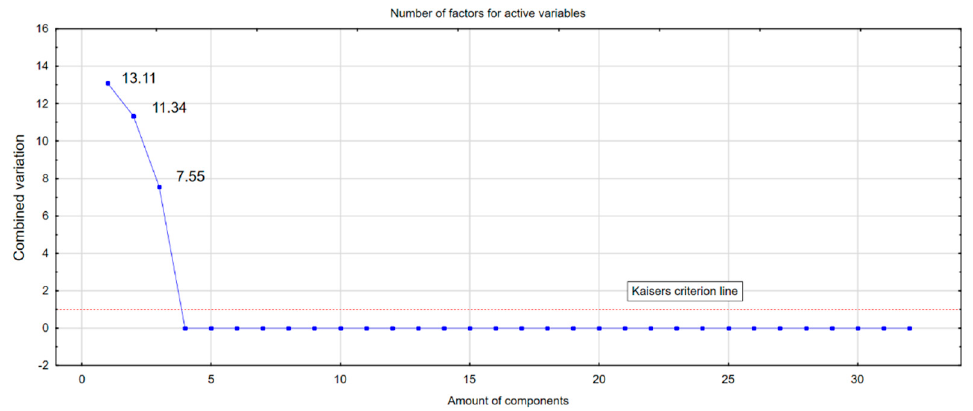
Figure 4. Settlement diagram.